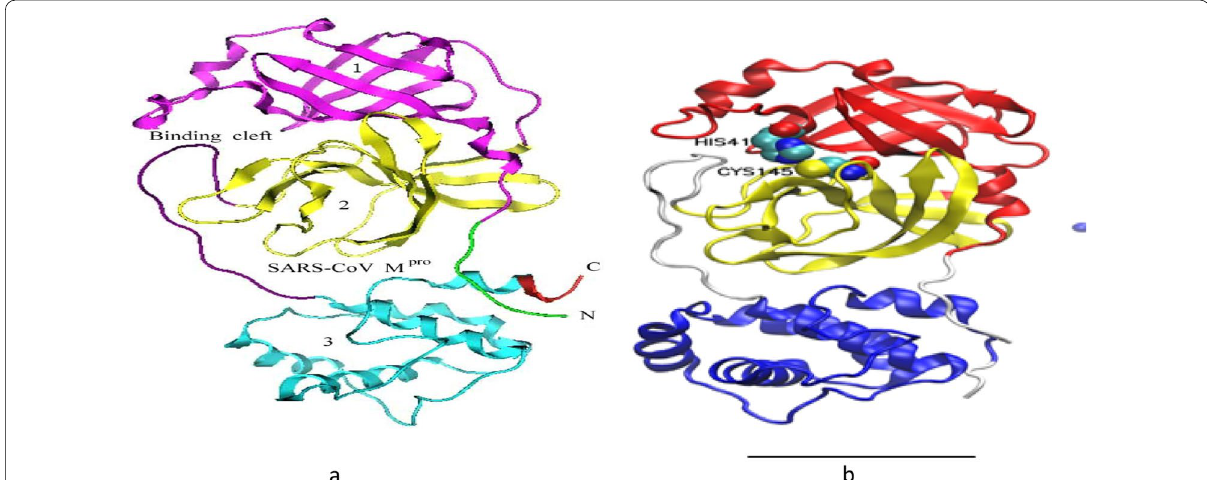
Fig. 2 a The ribbon representation of the crystal structure of the SARS-CoV-2 M pro from PDBID: 6Y2E. Domains I, II and III are displayed in pink, yellow and light blue (teal) respectively. The connection region between II and III are in red (C), green (N) and violet (binding cleft). b The ribbon representation of the crystal structure of the SARS-CoV-2 M pro from PDBID: 6Y2F. Domains I, II and III are displayed in red, yellow and blue respectively. The connection region between II and III is in white and the catalytic dyad residues (His41 and Cys145) are in solid sp